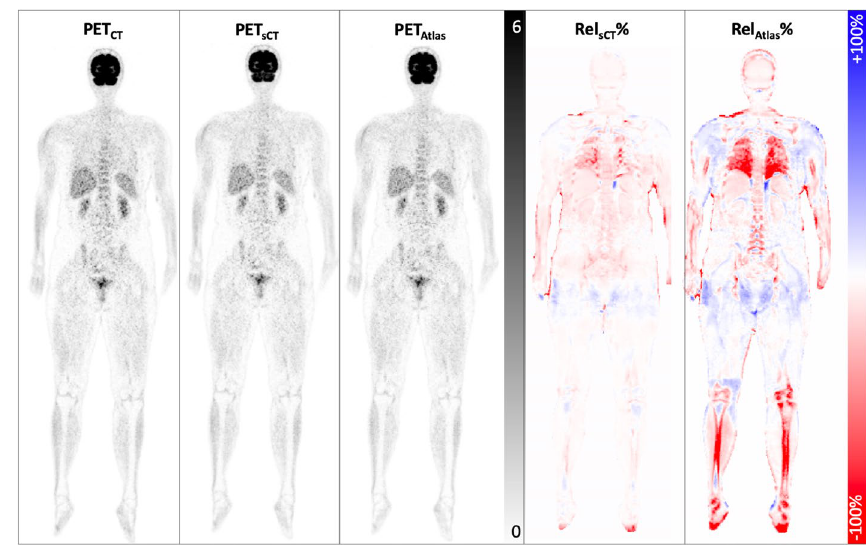
Fig. 2 Representative images showing reference PET CT , PET sCT , and PET Atlas images as well as the corresponding relative difference map of PET sCT and PET Atlas as compared to the reference PET CT